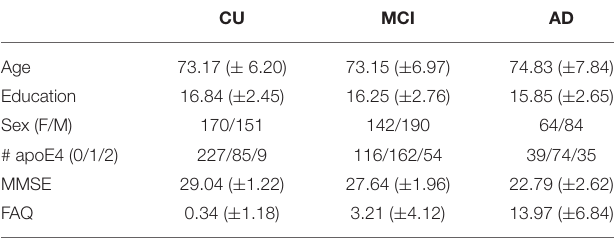
TABLE 1 | Multivariate CSF effects on brain morphology along the AD